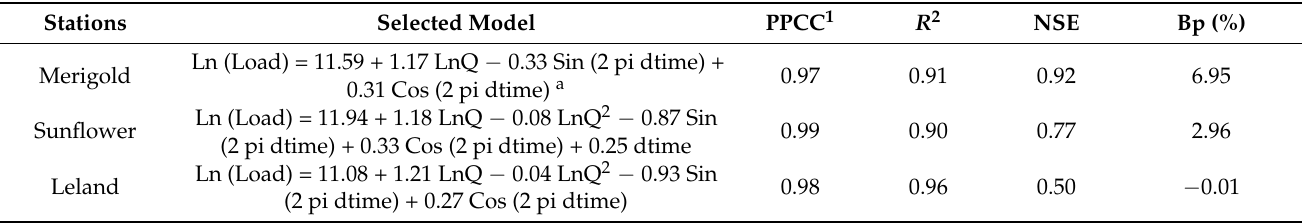
Table 6. Calibration results of regression models for TSS load at different